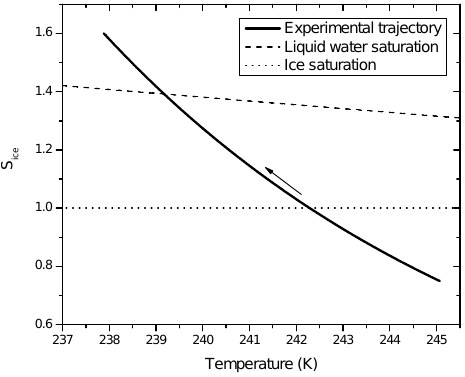
Fig. 1. Typical experimental trajectories for the ice nucleation ex- periments. Experiments start below ice saturation and the tempera- ture is decreased until ice crystals are observed.